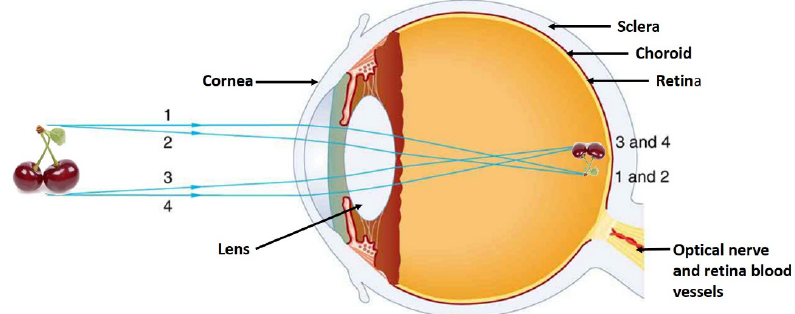
Figure 1. Schematic diagram of the human eye and image formation on the retina. Rays from the top and bottom of the object (1 and 2; 3 and 4) are traced and produce an inverted real image on the retina. The distance to the object is drawn smaller than scale. Adapted from [42].